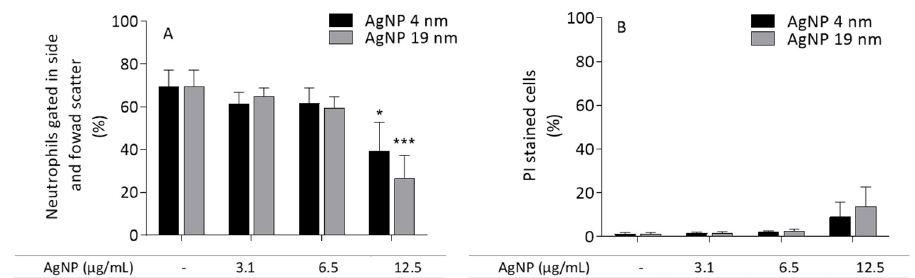
Figure 12. Flow cytometric analysis of human neutrophils incubated with 4- and 19 nm AgNP, using the PI staining method. ( A , B ) graphics summarize the results obtained in the neutrophils gated in side and forward scatter, and PI-stained cells, respectively. * p < 0.05 and *** p < 0.001 when compared with the control (untreated cells). Values are presented as the means ± SEM ( n ≥ 4).